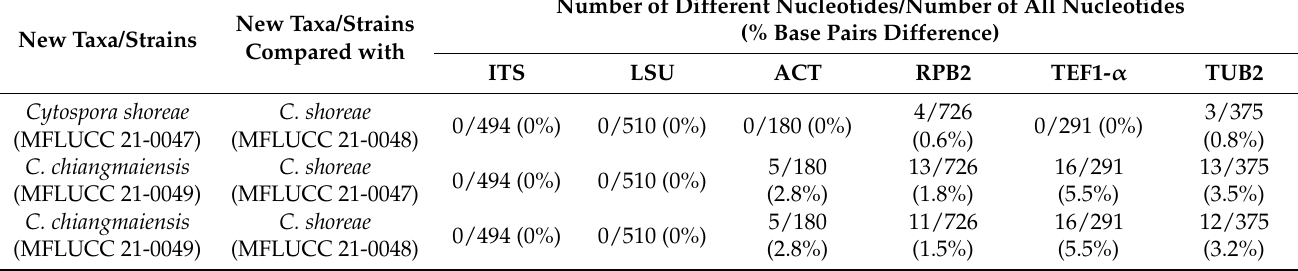
Table 3. Nucleotide differences of Cytospora species discussed in this study.